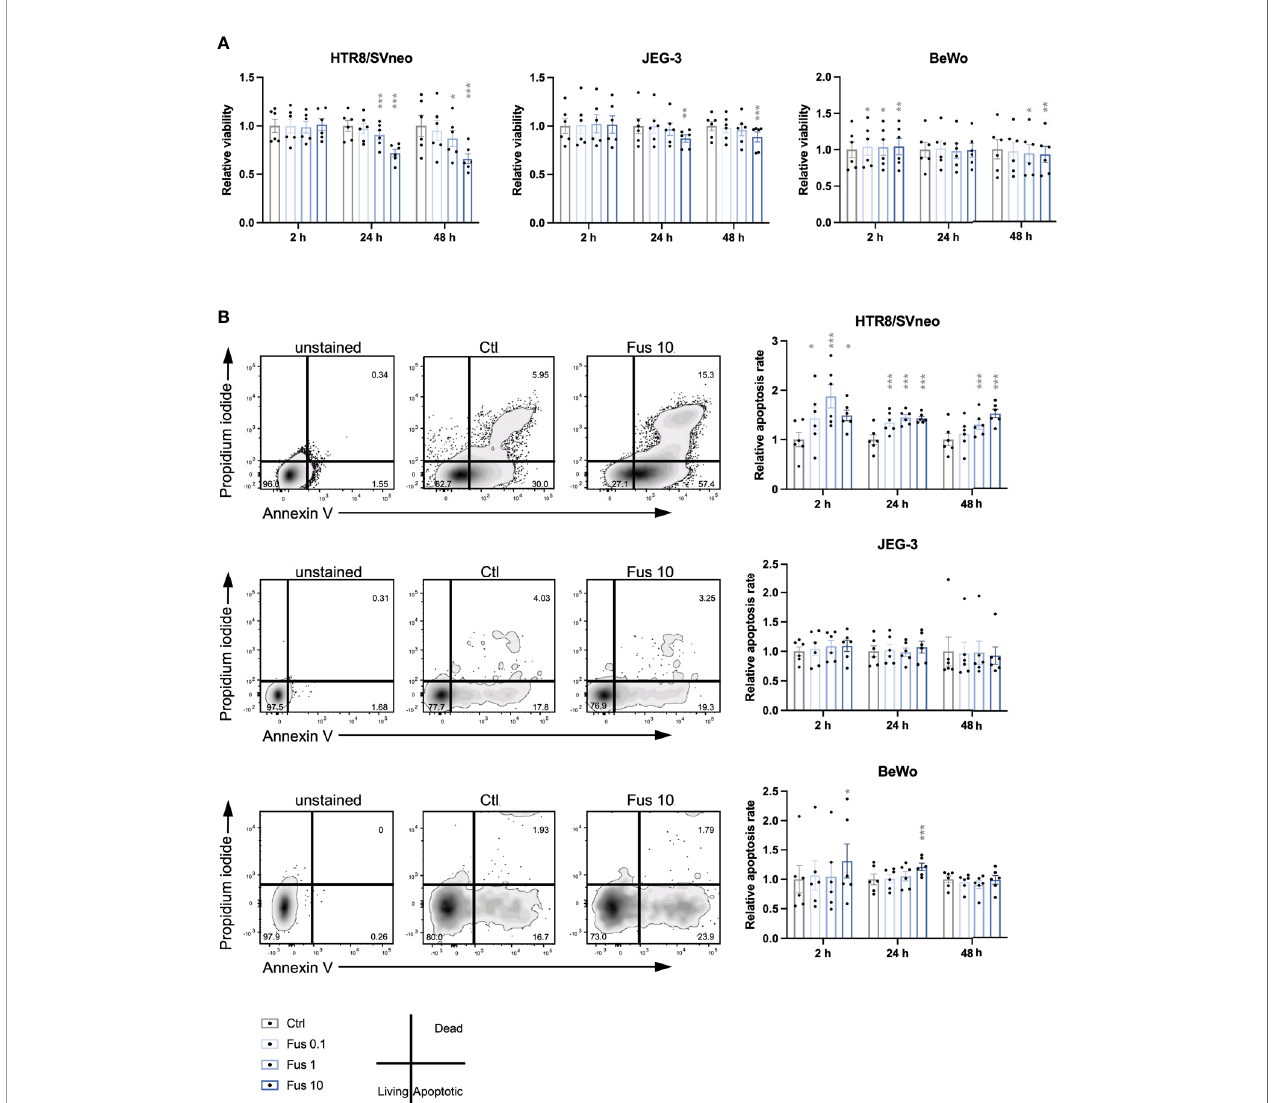
FIGURE 1 | Reduced viability and increased apoptosis rate of HTR8/SVneo cells was seen in response to high concentrations of inactivated F. nucleatum. Bar graphs represent viability of trophoblast cell lines after stimulation with F. nucleatum normalized to respective controls (A) . Representative plots for the analysis of apoptosis rate of HTR8/SVneo, JEG-3 and BeWo cells by fl ow cytometry ( B left). Bar graphs show apoptosis rate of trophoblast cell lines after stimulation with F. nucleatum normalized to respective controls ( B right). Normalized data represent the quotient of each value to the mean of untreated controls. Data are presented as mean ± SEM. *p adj < 0.05; **p adj < 0.01; ***p adj < 0.001 as analysed by Repeated Measures ANOVA with Dunnett ’ s multiple comparison post test, comparing each treatment against the corresponding control. Experiments were performed 6 times in sixtuplicate (A) or in triplicates (B) . Each point represents the mean value of the replicates for each experiment. Ctl, control; Fus, ratio of F. nucleatum to cell